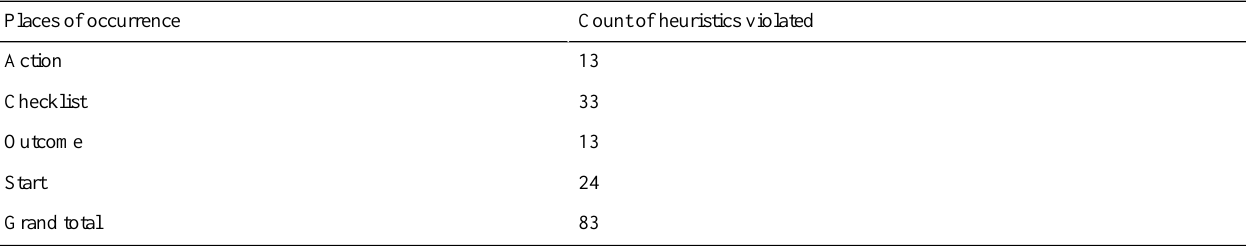
Table 4. Places of the heuristic violations occurrence.